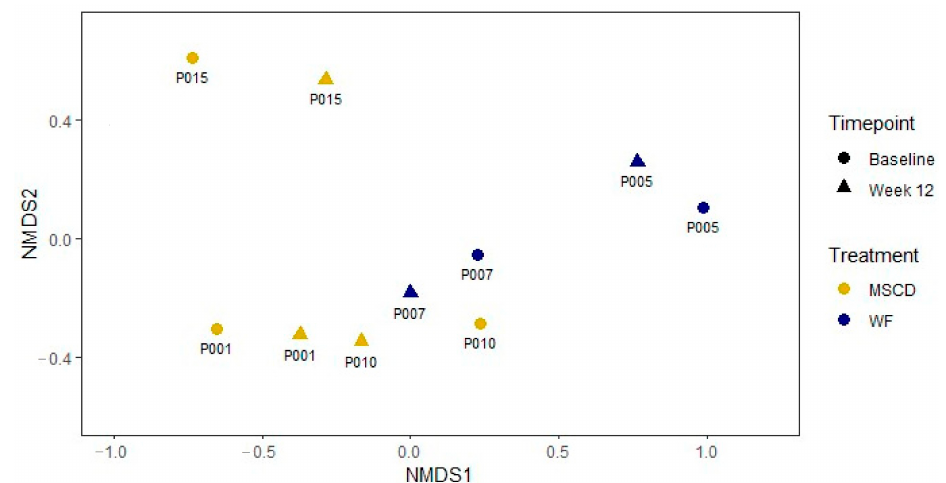
Figure 4. Microbiome community structure NMDS. Taxonomy of individual reads, as assigned by Kraken2, wascomparedbetweentimepoints(baselineandweek12only). Non-metricmulti-dimensional scaling was used to plot the data. The individuality of each patient’s microbiome is evident from patient-specific distances being closer than treatment-specific or timepoint-specific distances. The week 12 spread is less than the baseline spread, indicating more similar community composition following dietary